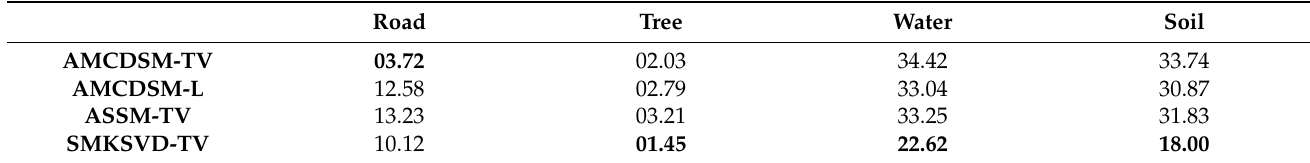
Table 2. Omission errors (%) of different classes, obtained applying different methods: Jasper ridge hyperspectral image. Road